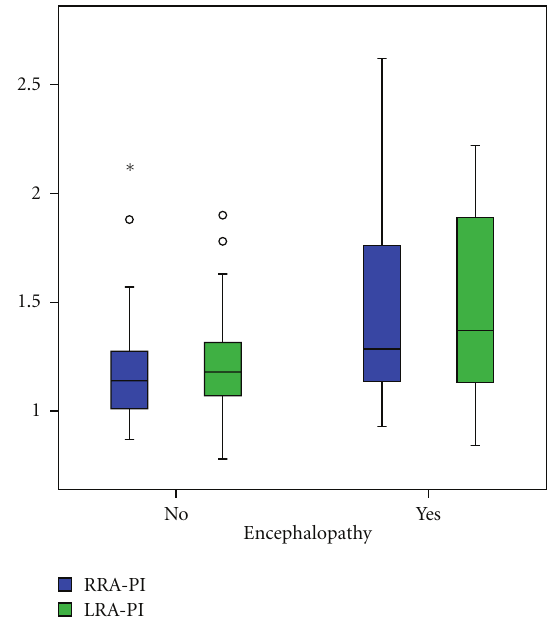
Figure 7: The values of RRA/LRA-PI in patients with presence or absence of hepatic encephalopathy. Table 6: Significant correlations between liver and renal Doppler US parameters. Surrogate markers of renal function